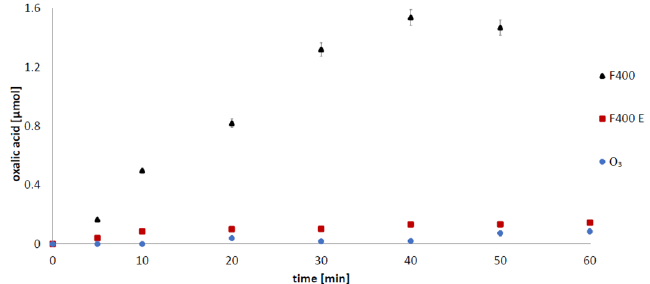
Figure 4. Impact of F400 carbon impurities on the amount of oxalic acid formed at pH 2.5 (2 g/200 ml): F400—unpurifed carbon, F400 E—purified carbon, O 3 —ozonation without activated carbon addition. Initial succinic acid concentration 1 mM.